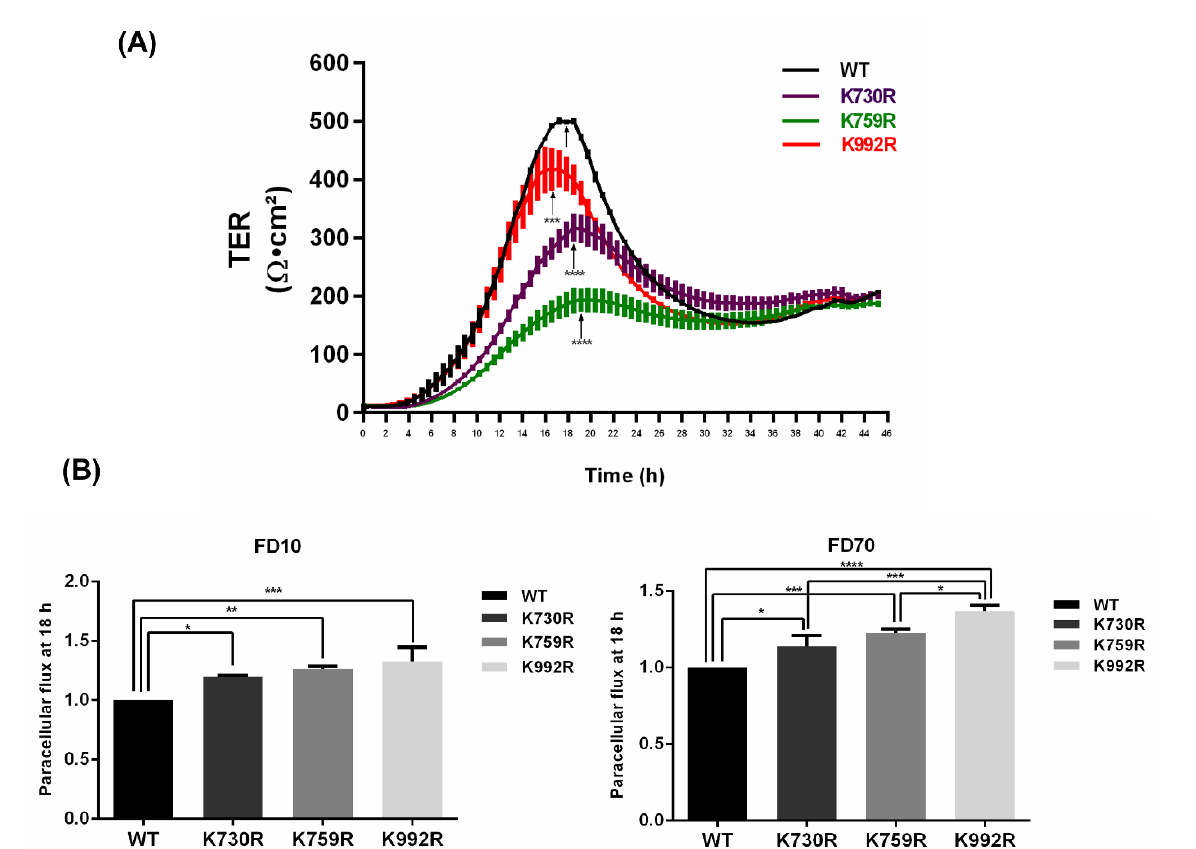
Figure 5. The expression of ZO-2 mutated in critical ubiquitination or SUMOylation target residues impairs TJ barrier function. MDCK monolayers were plated on Transwell inserts and one day later were transfected with Flag 3 -hZO-2 WT, the ubiquitination mutants FLAG 3 -hZO-2-K759R and -K992R, or the SUMOylation mutant FLAG 3 -hZO-2-K730R in DMEM without calcium and serum. After 6 h, monolayers were switched to DMEM with calcium and serum, and the TER values were continuously recorded using the CellZscope system after that. ( A ) Monolayers transfected with hZO-2 ubiq- uitination and SUMOylation mutants exhibit a lower peak of TER than those transfected with Flag 3 -hZO-2 WT. The graph presents the mean TER ± SD from 3 monolayers plated on Transwell inserts. The graph is representative of three inde- pendent experiments. Statistical analysis was done with One- way ANOVA followed by Bonferroni’s multiple comparison test, comparing the peak values of TER (arrows) of each tested mutant with that of Flag 3 -hZO-2 WT. *** p < 0.001, **** p < 0.0001. ( B ) Monolayers transfected with hZO-2 ubiquitination and SUMOylation mutants display at 18 h after the Ca- switch a higher paracellular passage of 10 kDa FITC-Dextran (FD10) and 70 kDa FITC-Dextran (FD70) measured in the apical to basolateral direction than those transfected with Flag 3 -hZO-2 WT. The graphs present the mean ± SD of three independent experiments. Statistical analysis was done with One- way ANOVA followed by Bonferroni’s multiple com- parison test. Values shown are normalized to control (Flag 3 -hZO-2 WT). * p < 0.05, ** p < 0.01, *** p < 0.001, **** p <